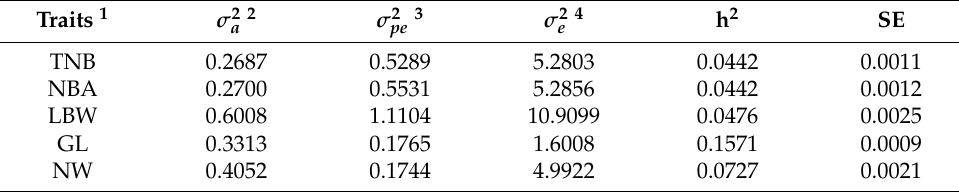
Table 2. Estimates of variance components and genetic parameters for five reproductive traits. Traits 1